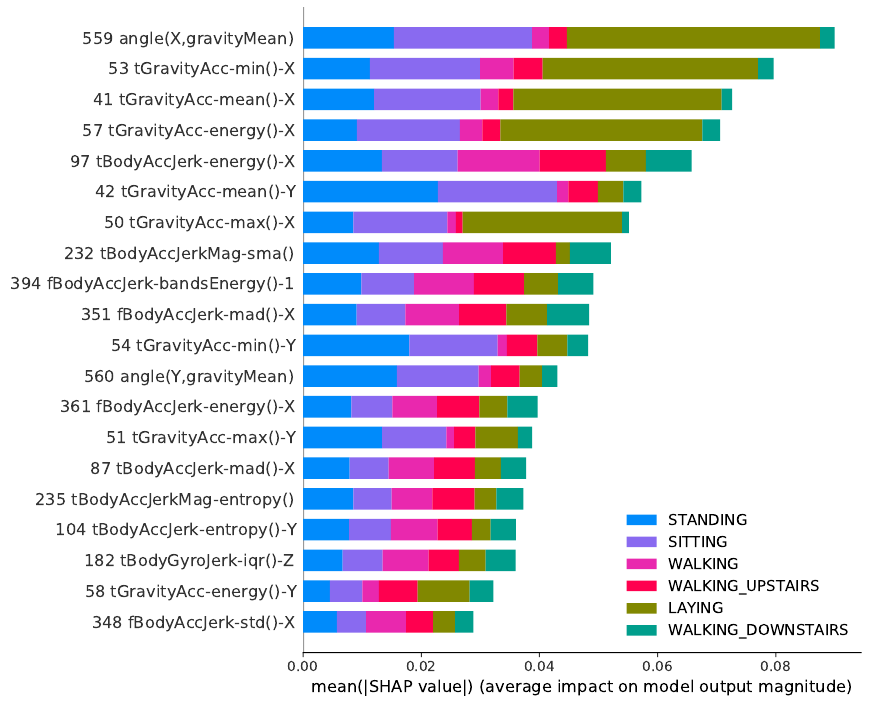
Figure 7. Summary plot for SHAP analysis using holdout methodology on UCI dataset. It shows the mean absolute SHAP value of 20 most important features for six activities.